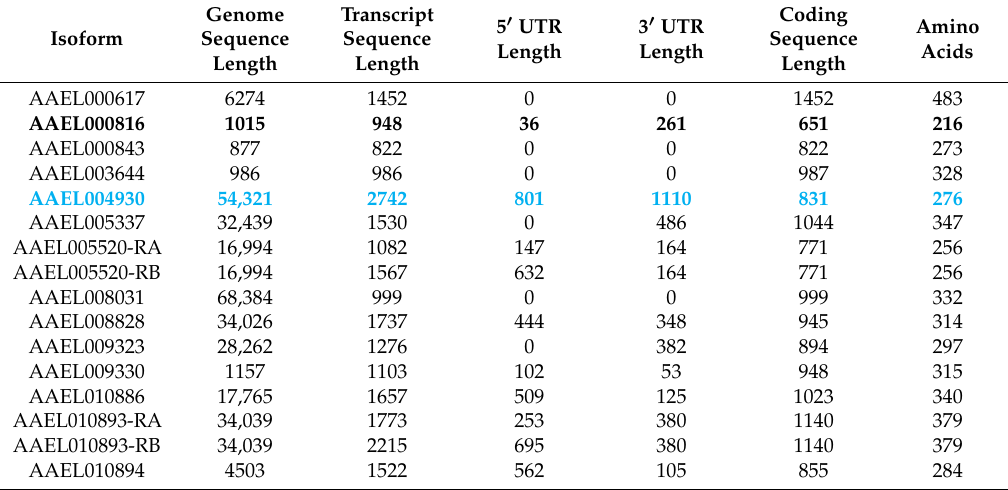
Table 1. Carbonic anhydrase genes in Aedes aegypti